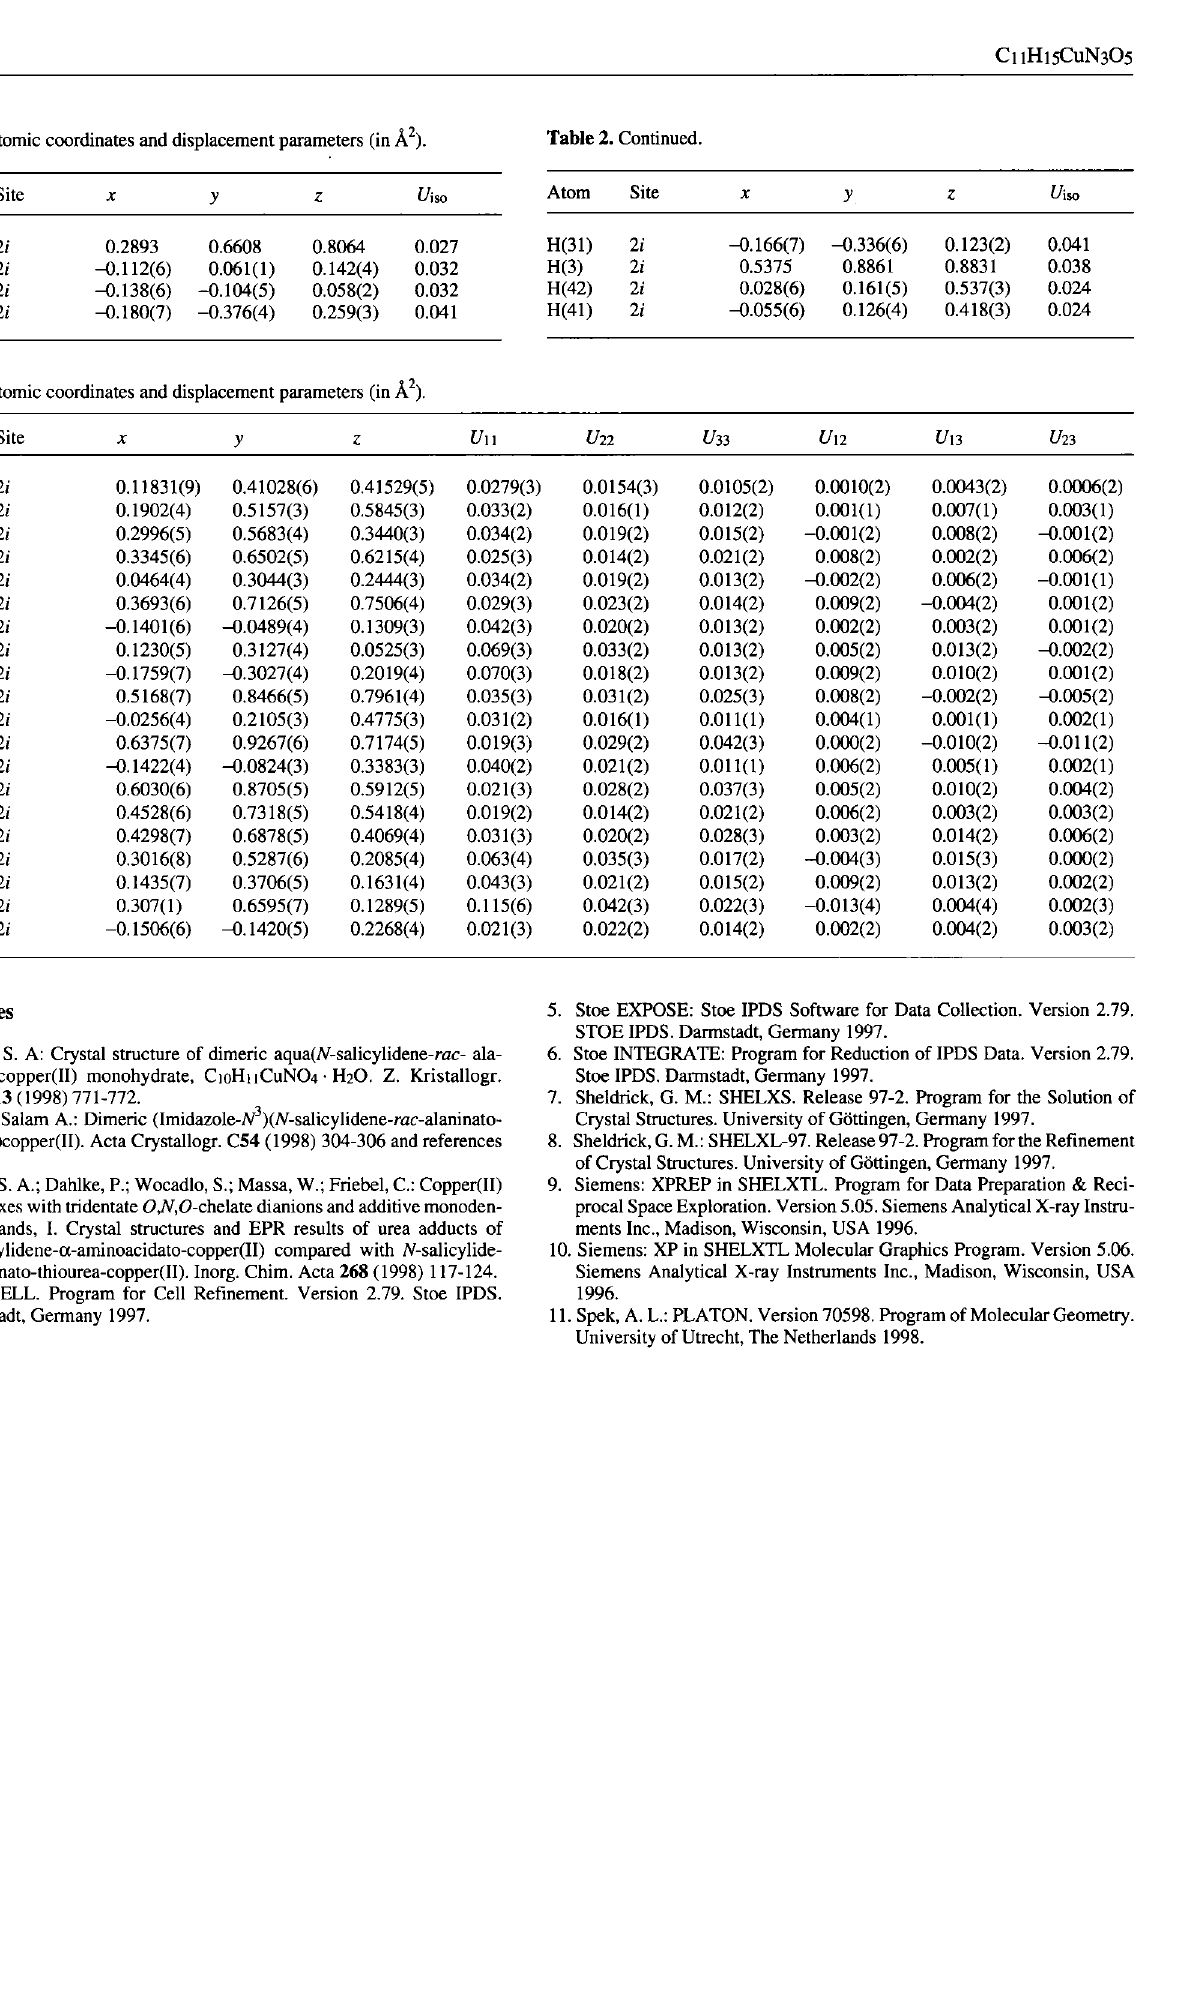
Table 3. Atomic coordinates and displacement parameters (in Â 2